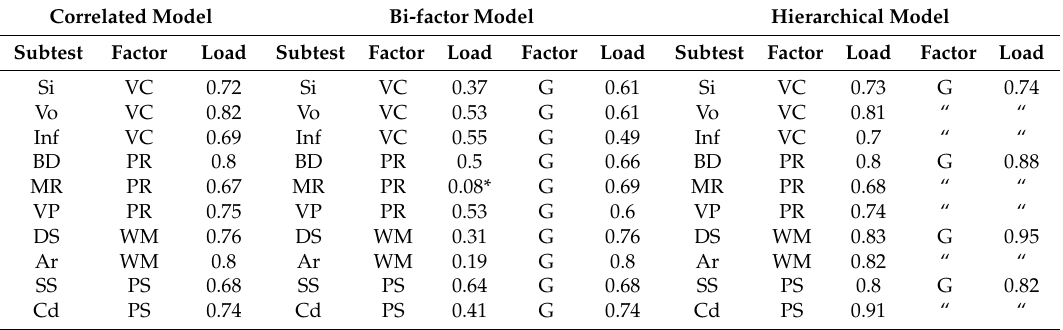
Table 3. Standardised factor loadings for correlated factors, bi-factor and hierarchical